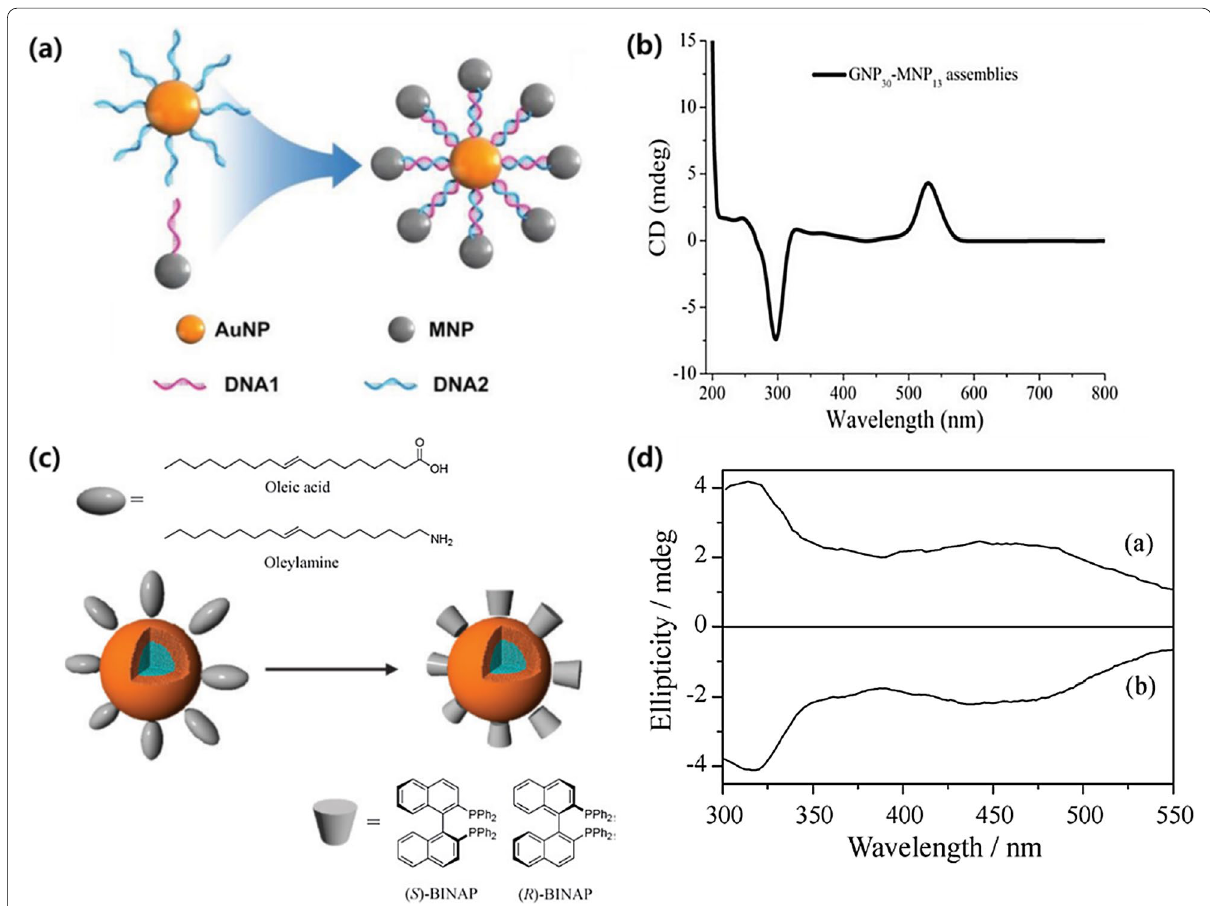
Fig. 6 a Schematic representation of gold-magnetite core-satellite chiromagnetic nanostructures and b its CD spectra. Reproduced with permission from [47]. Copyright 2021 Wiley. c Schematic representation of core (iron oxide, blue)-shell (palladium, orange) chiroptical NPs conjugated with ( S )-/( R )-BINAP and d their CD spectra. Reproduced with permission from [48]. Copyright 2009 Royal Society of